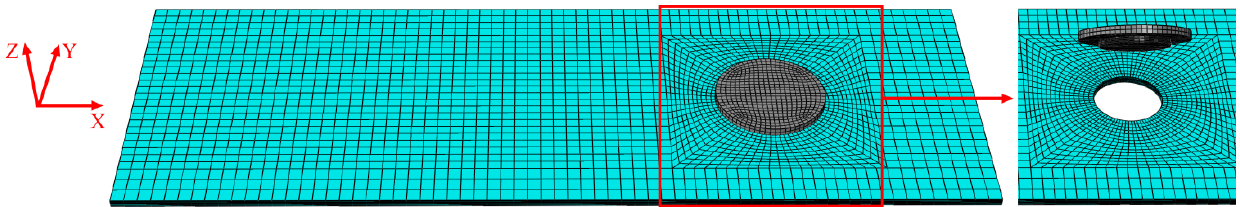
Figure 14. FE model of the bolted CFRP laminate specimen with the global coordinate